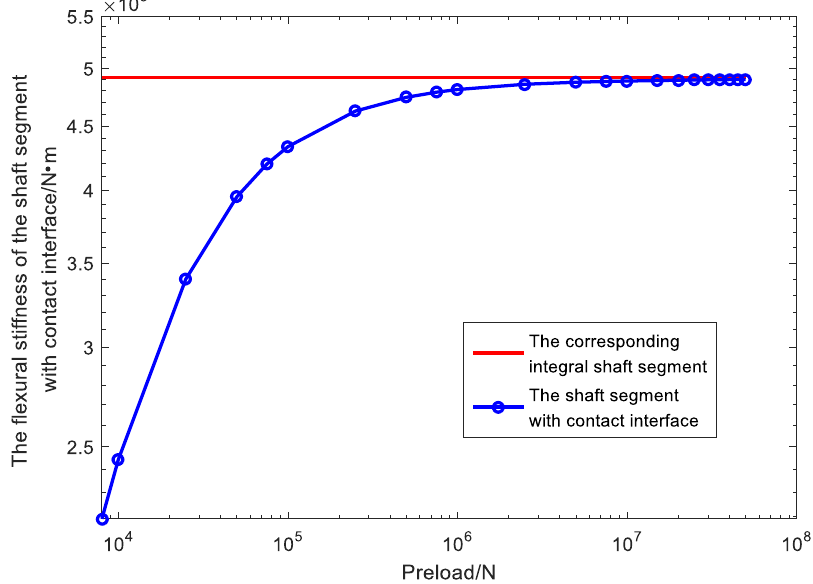
Figure 10. EFS of the shaft segment with contact interface changes with preload.